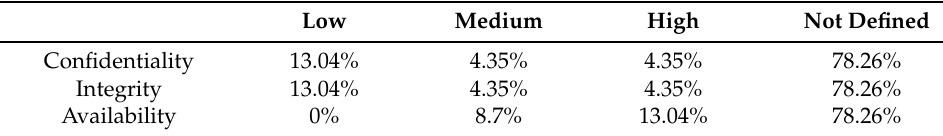
Table 3. The CIA flag distribution for environment A.